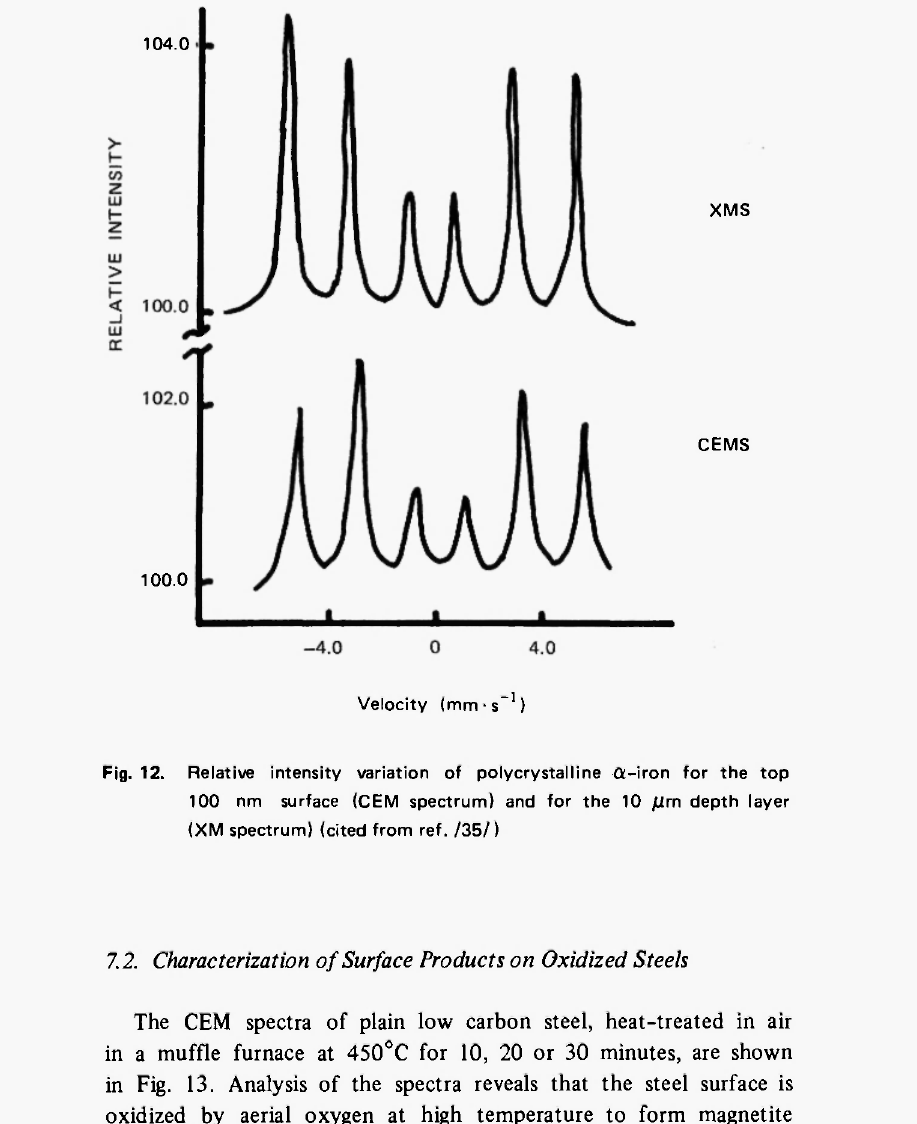
Fig. 12. Relative intensity variation of polycrystalline α-iron for the top 100 nm surface (CEM spectrum) and for the 10 /Urn depth layer (XM spectrum) (cited from ref.